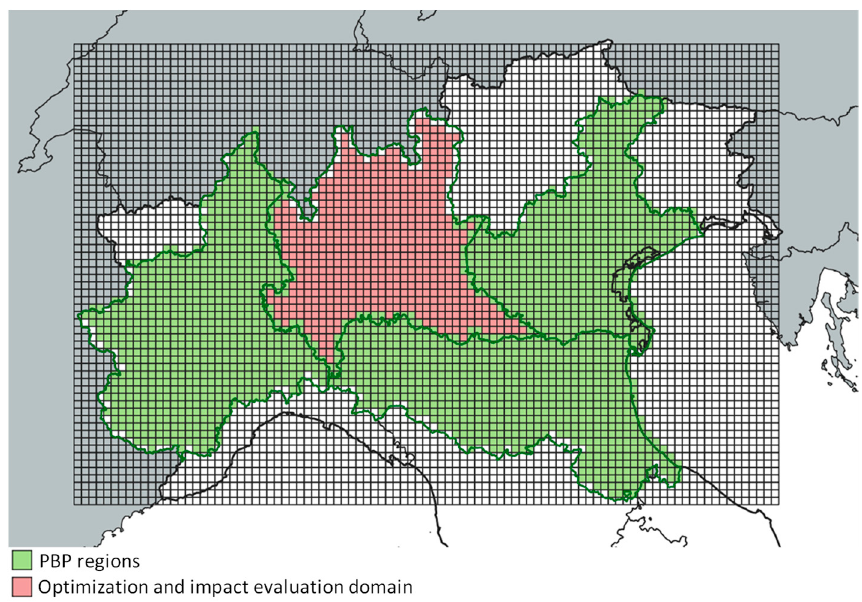
Figure 2. MAQ model domain. Multi-objective optimization and scenario analysis results are evaluated over Lombardia region (pink cells). The Po Basin Plan (PBP) is applied in Lombardia, Piemonte, Emilia Romagna, and Veneto (green cells).